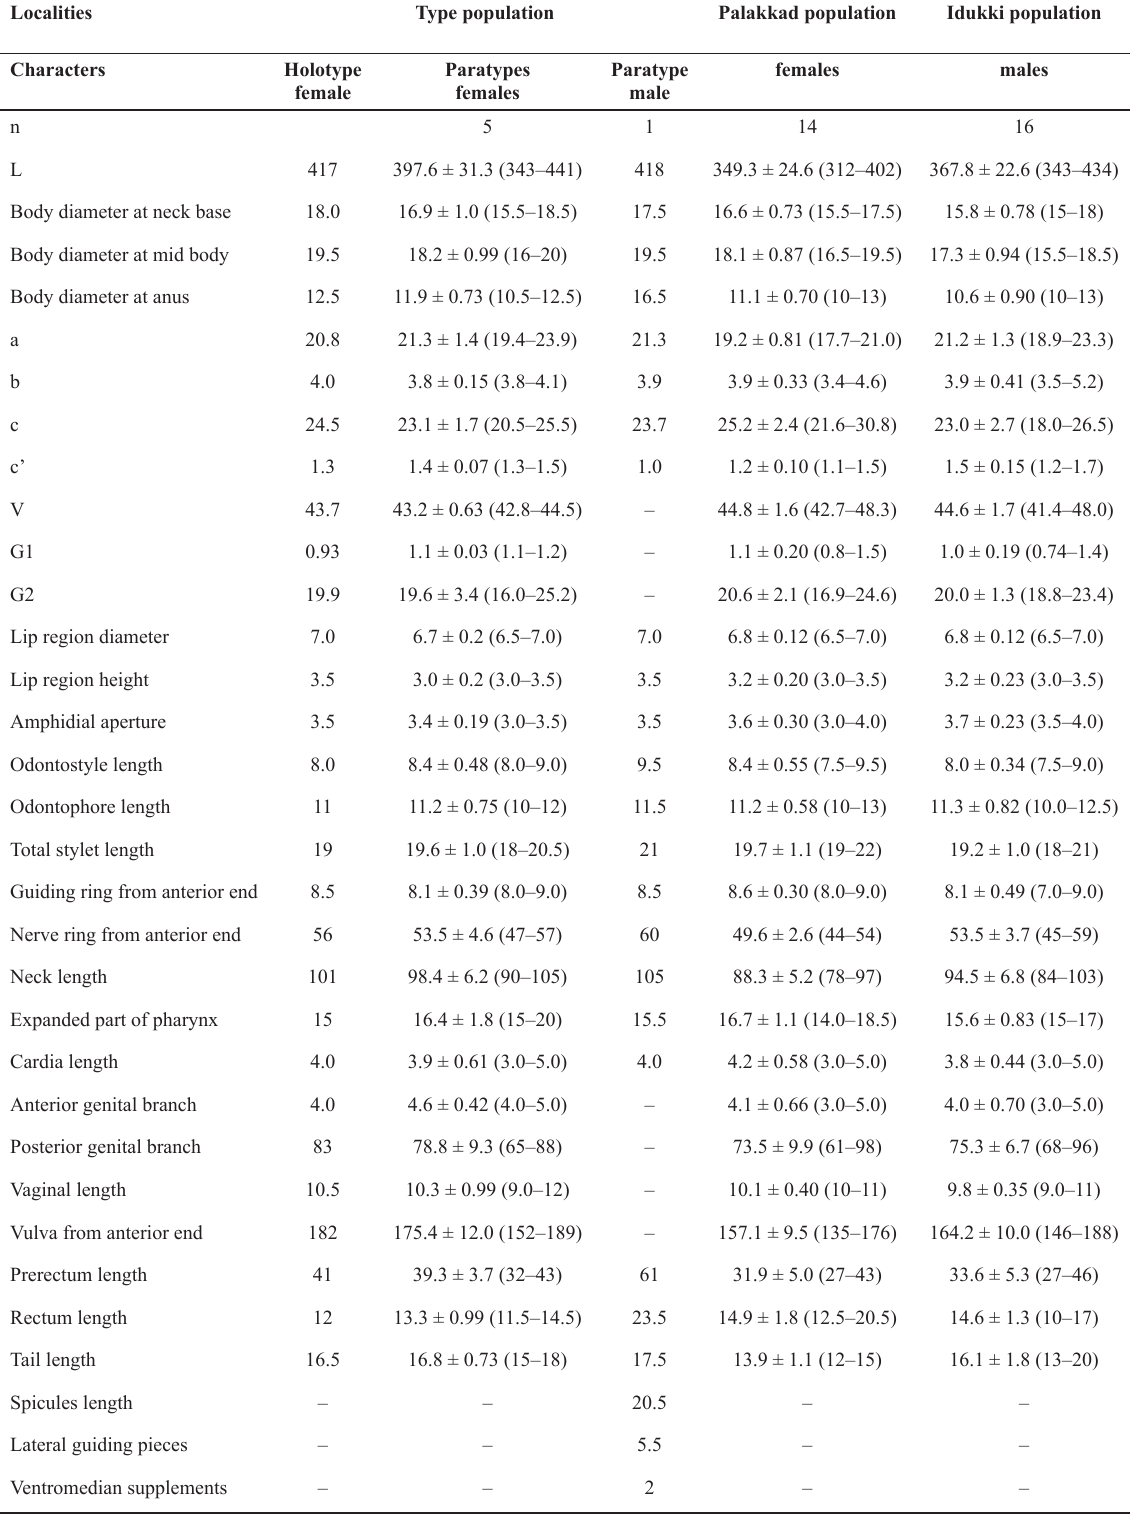
Table 10. Measurements of Basirotyleptus neocaudatus sp. nov. All measurements are in μm and in the form: mean ± s.d.